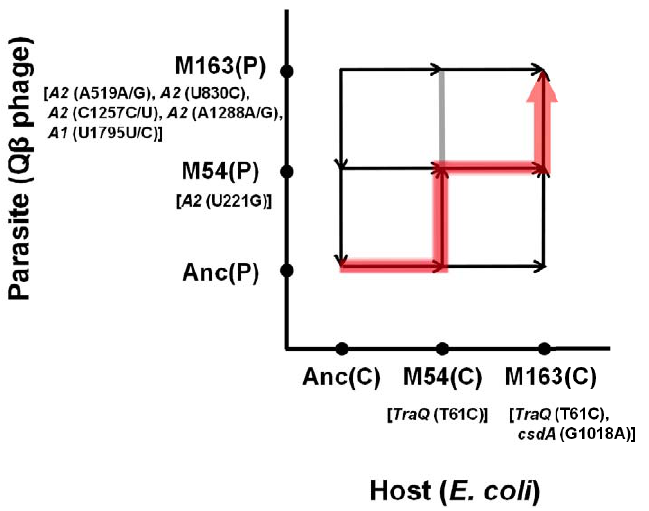
Figure 8. Estimation of evolutionary path. The direction of the arrowhead on each arrow indicates higher fitness. The gray line at M54(C) indicates that M54(P) and M163(P) showed almost equivalent fitness on M54(C). The red line indicates the plausible route for fixing M163(C) and M163(P) in this study. The genes in which mutations compared with the ancestor and detected only in the copropagation regime are shown in brackets, and the mutation positions in each gene for E. coli and in the Q b genome are shown in